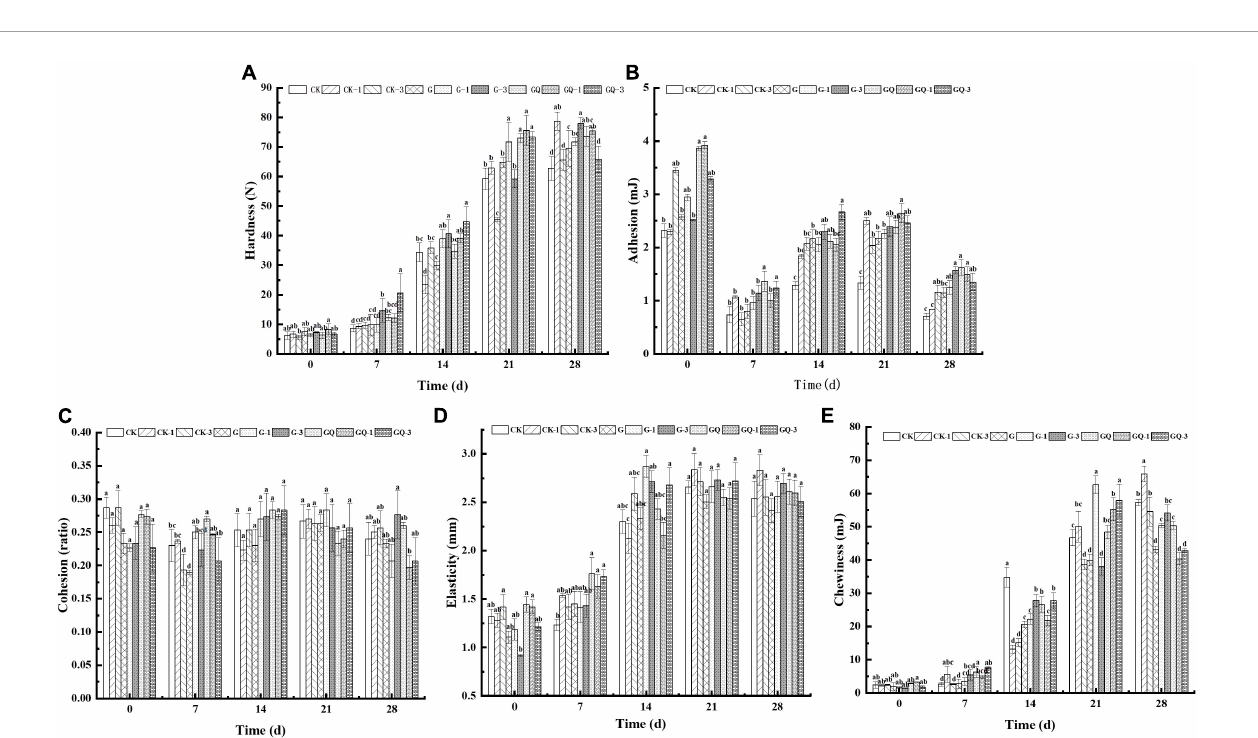
FIGURE2 Changes in the texture of sausages, including hardness (A) , adhesion (B) , cohesion (C) , elasticity (D) , and chewiness (E) , among treatments during the fermentation for 0, 7, 14, 24, and 28 days. Different lowercase letters (a–d) indicate a significant difference between different treatment groups at the same fermentation time ( P < 0.05). The group without starter culture and leucine was assigned to the CK group. The groups added with 1 and 3 mM of leucine without starter culture were assigned to the CK-1 and CK-3 groups, respectively. The group with Lactobacillus fermentum YZU-06 was assigned to the G group. The groups with Lactobacillus fermentum YZU-06 and different concentrations of leucine (1 and 3 mM) were named G-1 and G-3 groups, respectively. The fermented sausage with the mixed-starter cultures of Lactobacillus fermentum YZU-06 and Staphylococcus saprophyticus CGMCC 3475 was assigned to the GQ group. The groups with the mixed-starter cultures and different concentrations of leucine (1 and 3 mM) were named GQ-1 and GQ-3 groups,